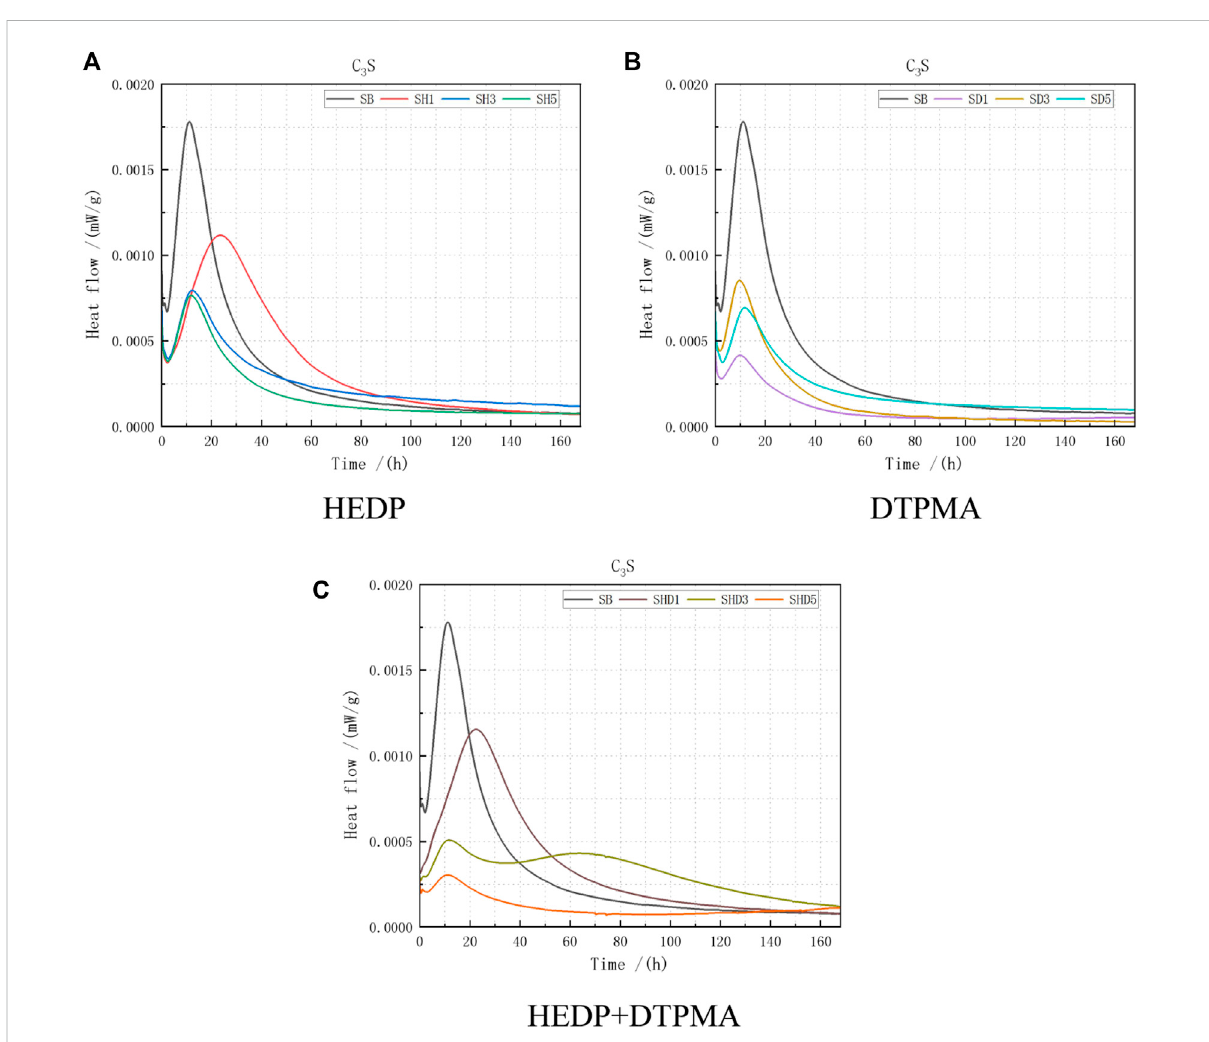
FIGURE 3 Heat fl ow data obtained from C 3 S combined with the following: (A) HEDP, (B) DTPMA, and (C) HEDP + DTPMA.